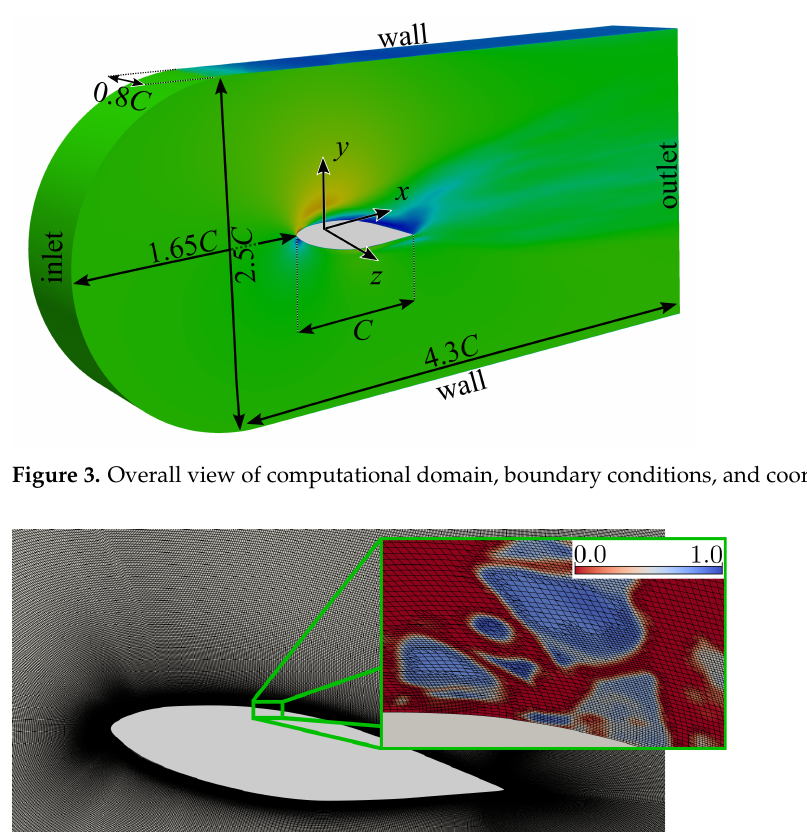
Figure 4. Computational mesh around hydrofoil in the x vapor field (cid:101) α to demonstrate dynamic mesh refinement